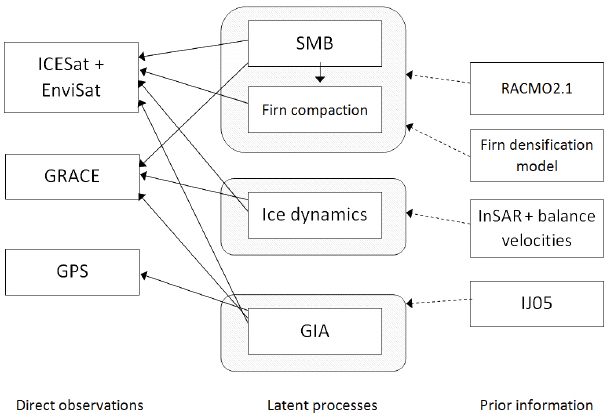
Figure 2. Schematic diagram showing the relationship between the observations, the process model defining the latent processes, and the priors